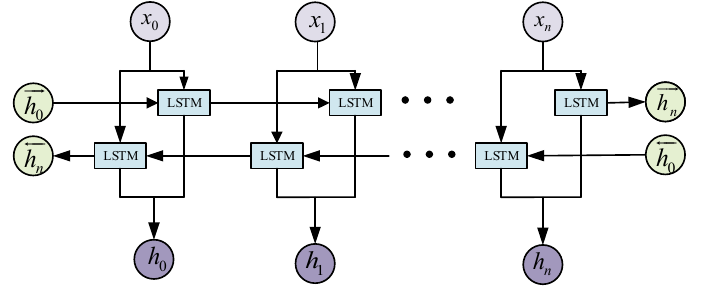
Figure 5. BiLSTM network model.